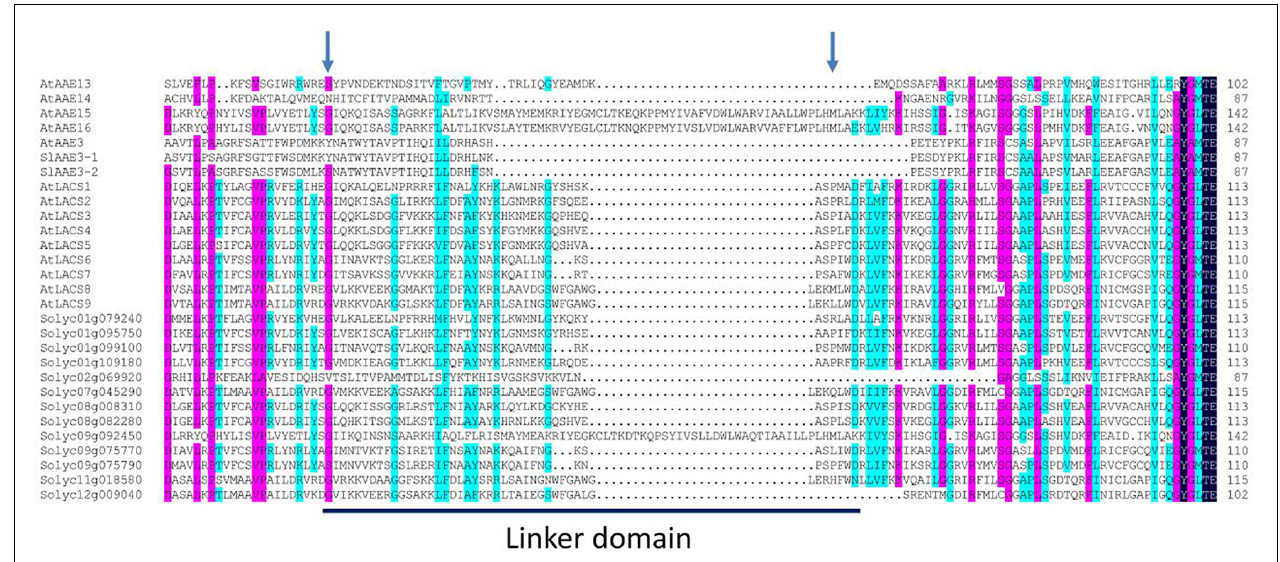
FIGURE 2 | Multiple sequence alignment and linker domain structure of clade I proteins. The sequences of all acyl-activating enzyme (AAE) subfamily I proteins were aligned by DNAMAN software, and the sequence alignment and linker domain annotation were performed according to the reported sequence alignment results of Arabidopsis (Shockey et al., 2002). The blue arrows indicate the left and right boundaries of the linker domains, and the amino acid sequences in the horizontal line indicate the linker domains.